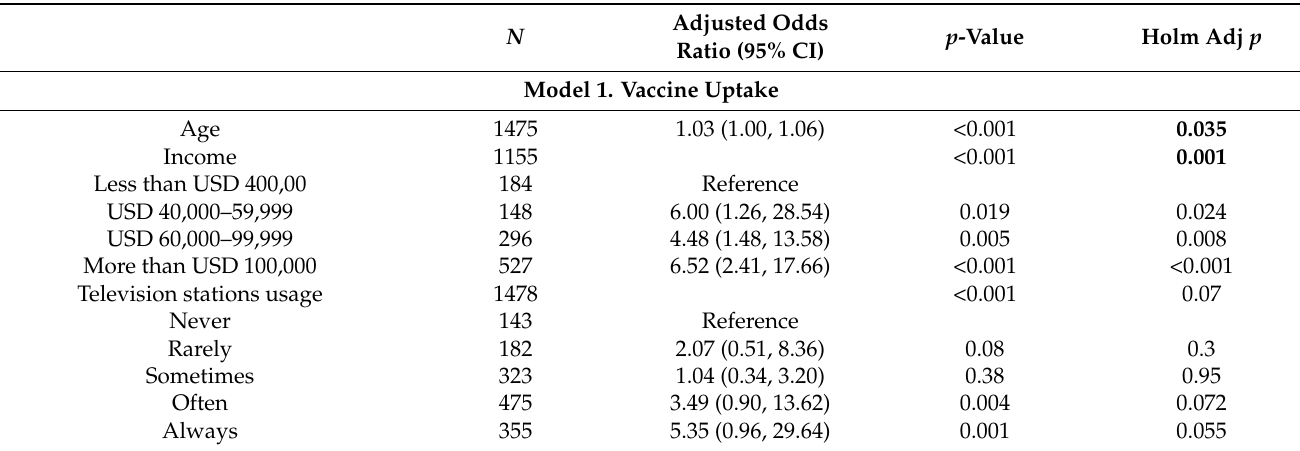
Table 12. Multivariate